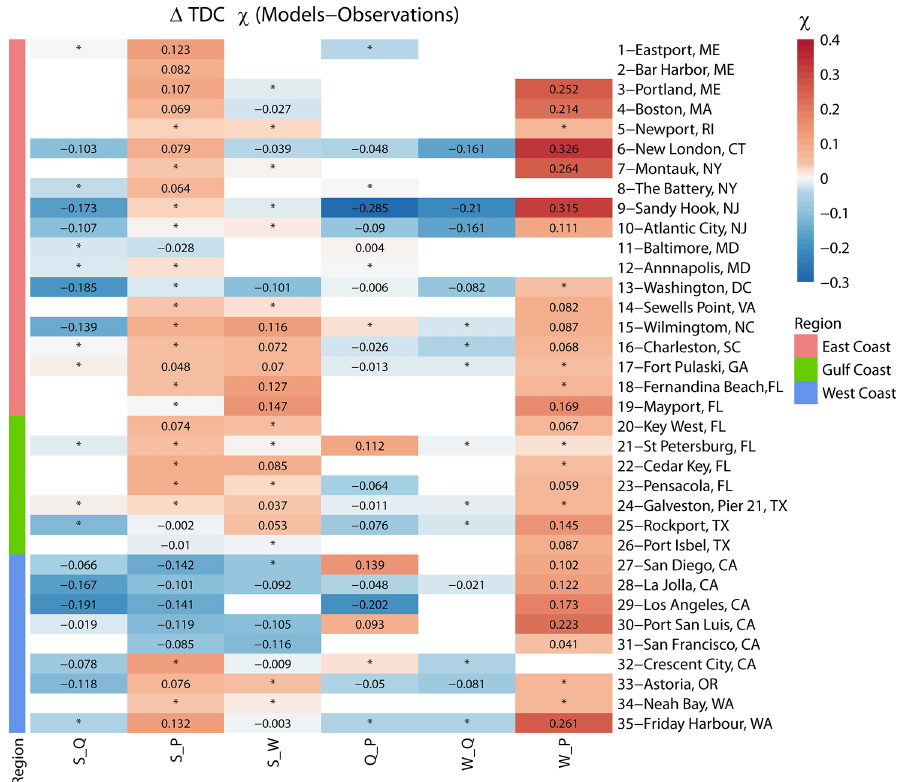
Figure 10. Heat map showing differences in tail dependence (for q = 0 . 9) derived for models (reanalysis) and observations using a daily time series of both variables. Sites are grouped into locations on the East, Gulf, and West coasts (see colours on the left and in the legend). The colour bar denotes the difference between χ in the reanalysis versus observations, where the red colour denotes higher dependence in the reanalysis, and the blue colour denotes higher dependence in the observations. Squares with an asterisk ( ∗ ) indicate that difference in dependence is not significant. Blank squares indicate that data for the particular pair did not exist or that the number of overlapping years was less than 20.